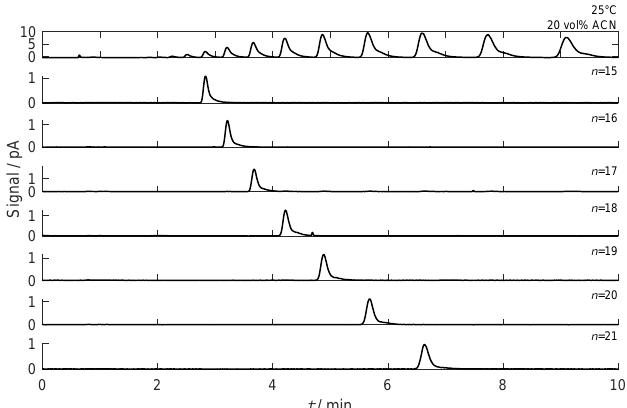
Figure 12. Analysis of the fractions collected during the preparative runs as marked in Figure 11. Top row —Feed mixture (1 g/L PEG 1000 in water). Further rows —Individual fractions. Conditions: analytical column, 20 vol% ACN, 25 ◦ C, 1 mL/min, injection volume 10 µ